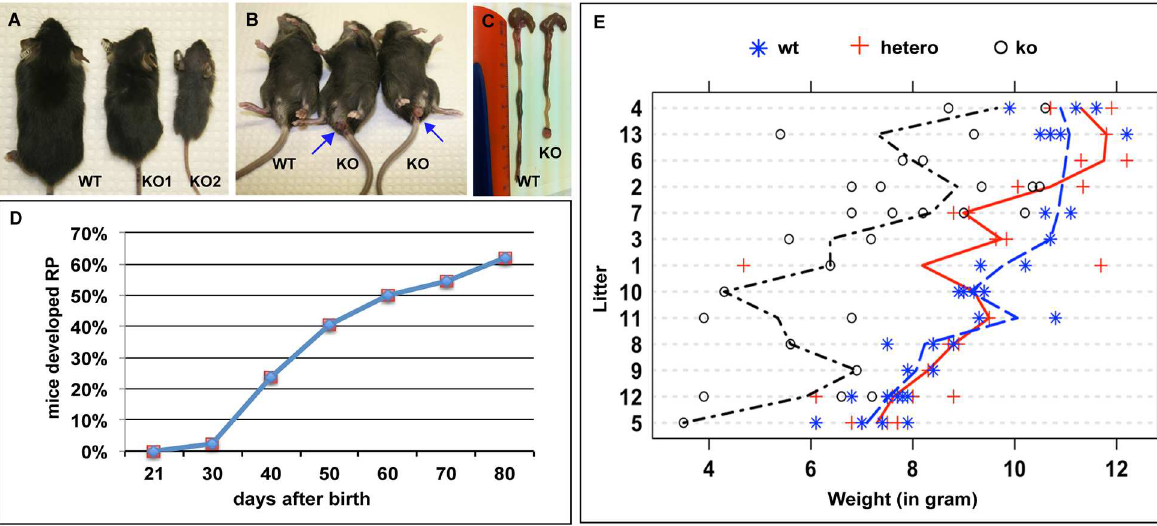
Fig 2. The IEC-specific hnRNPI knockout mice have low body weight and develop rectal prolapse. (A) Size difference betweenthe knockout mice (KO) and their control littermate (WT) at the time of weaning.The knockout mouse labeledas KO2 weighted50% less than the control mice and died within three days after weaning.(B) The knockoutmice developrectal prolapse(arrows). (C) Gross morphology of the colons from a knockout mouse and its control littermate. The mutant colon is short with prolapsedrectum. (D) Timelineof rectal prolapse development in the knockout mice within 80 days after their birth (n = 41). (E) Statistical analysisusing R shows low body weights of the adult knockout mice when comparedto those of their control littermates. Total 13 litters (100 mice) agedbetweenday 20 to day 28 from the cross of hnRNPI flox/+ ; Villin Cre/+ mice with the hnRNPI flox/flox mice were analyzed.“ * ”, “+”, and “o” in the graph indicate the genotypeand weight of the individual mouse analyzed.The weight differencesbetweenko and wt, or ko and hetero, are all statistical significantwith p-valuesless than 0.001. The difference betweenthe two control groups (hetero vs wt) is not significant.wt, wild-type, which includes hnRNPI flox/+ mice and hnRNPI flox/flox mice; hetero, heterozygote ( hnRNPI flox/+ ; Villin Cre/+ ); ko, knockout ( hnRNPI flox/flox ; Villin Cre/+